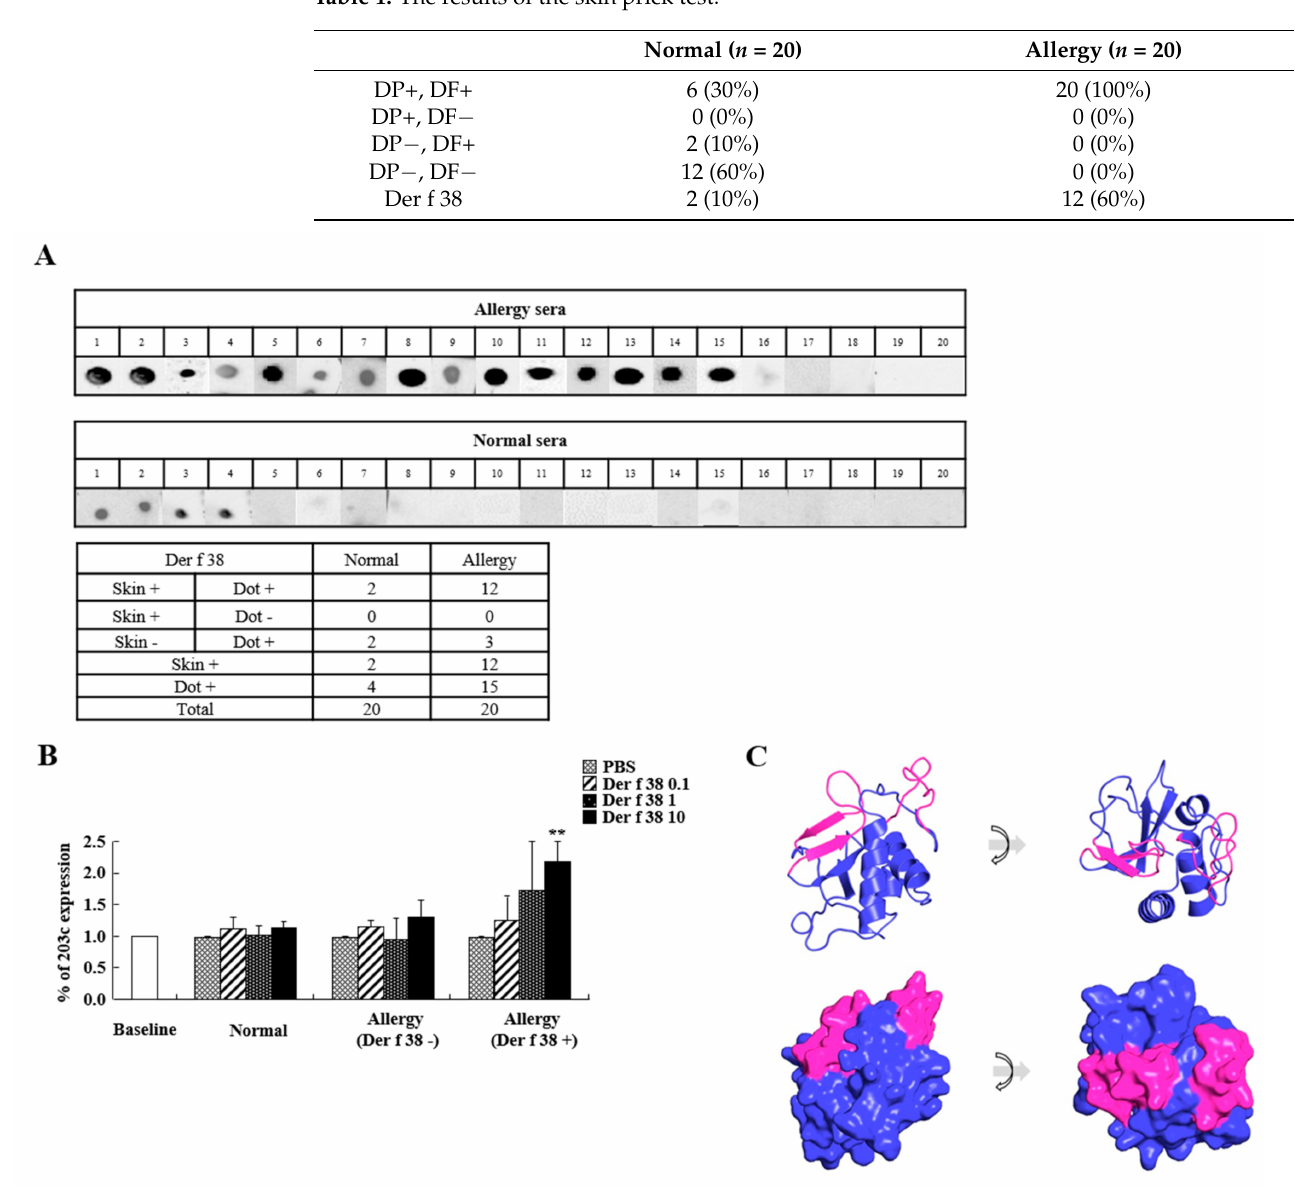
Figure 2. IgE reactivity and basophil activation of Der f 38. ( A ) A dot blot assay was performed to detect IgE reactivity of Der f 38 using sera of normal and allergic subjects (upper panel). Comparison of skin prick test results with dot blot